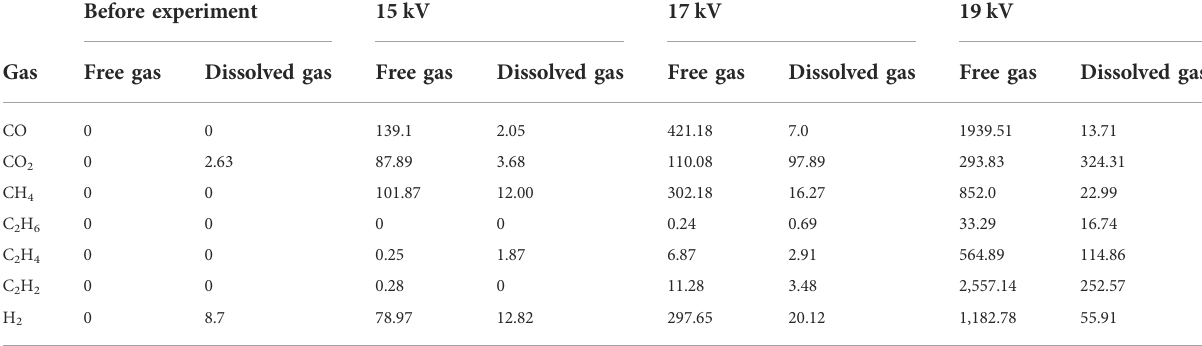
TABLE 1 Surface discharge defect model under different severity of oil surface gas and dissolved gas in oil (unit: μ L / L ). Before experiment